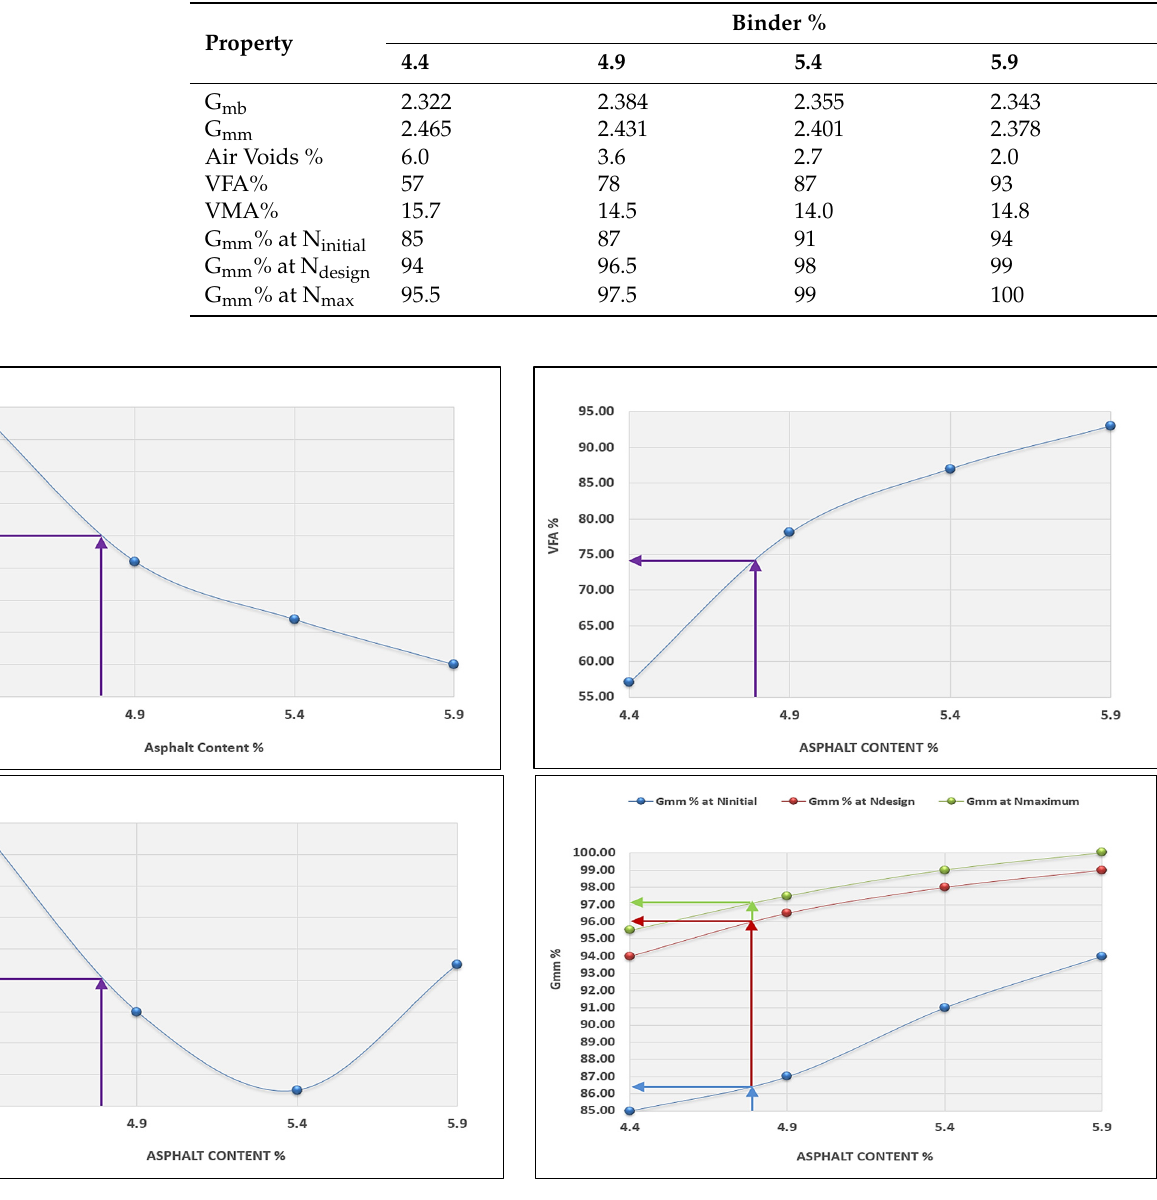
Table 18. The added percentages of virgin binder to the recycled mixtures.